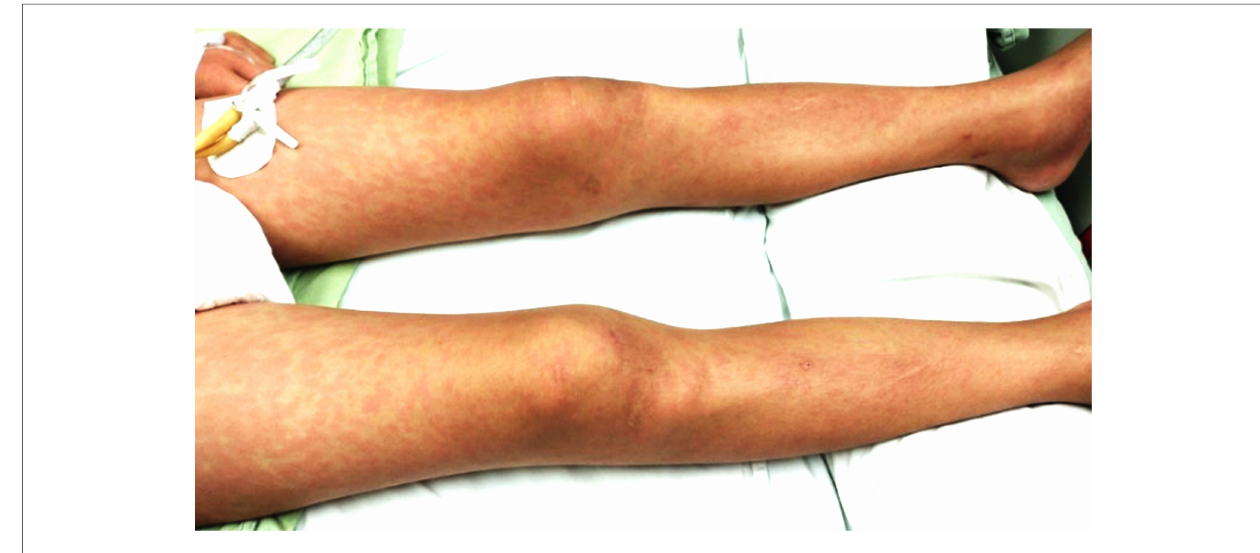
FIGURE 1 Maculopapular rash on the lower